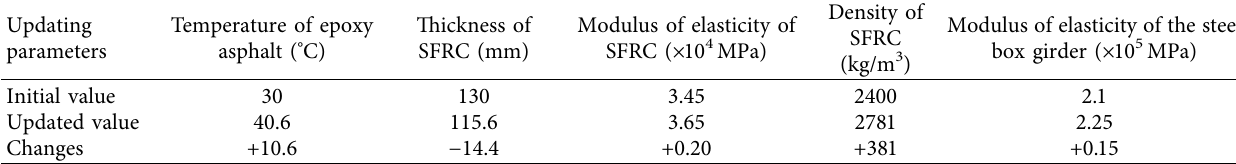
Table 4: Final value of the updated parameter for the FEM model.